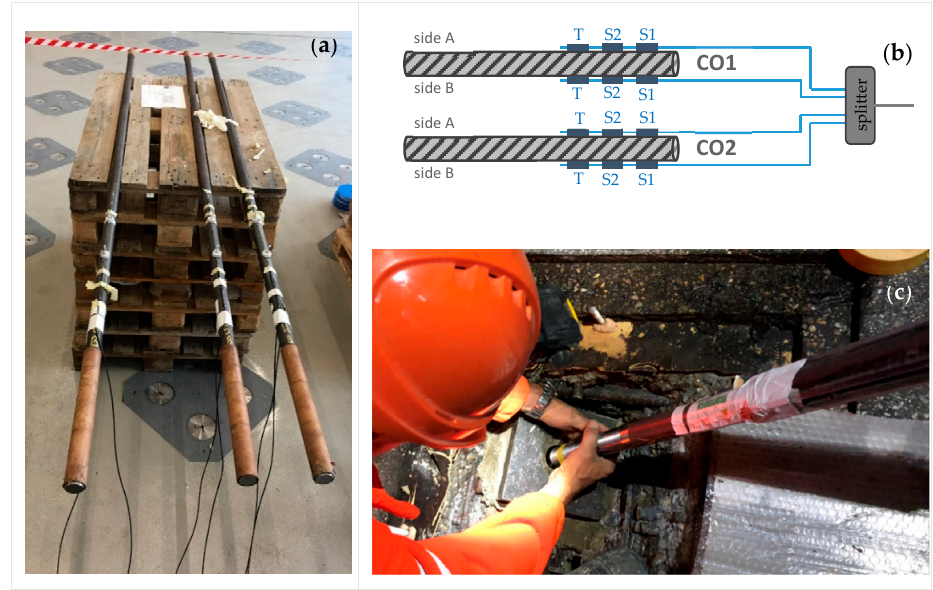
Figure 4. ( a ) Assembling of the optical sensors in the laboratory; ( b ) location of the strain (S) and temperature (T) sensors at each Gerber hinge, here, hinge C; ( c ) inserting a rod into the borehole.